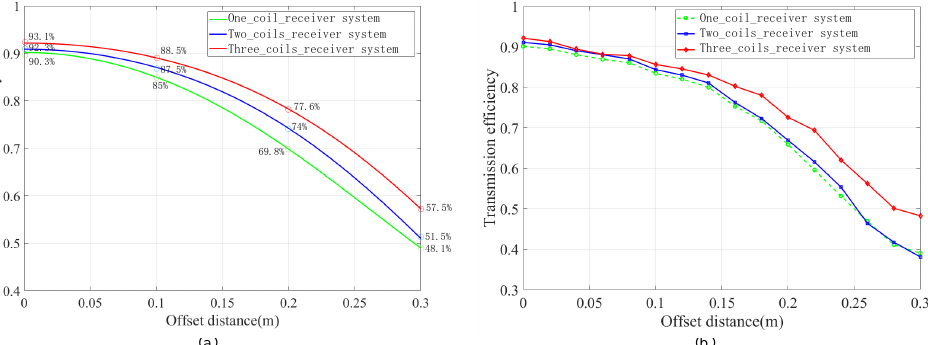
Figure 11. Comparison of efficiency vary with offset distance. ( a ) is the simulation result, and ( b ) is the experimental result. The θ of one-coil-receiver system, two-coils-receiver system and three-coils-receiver system are θ = 0, θ = π /4, and θ = π /3